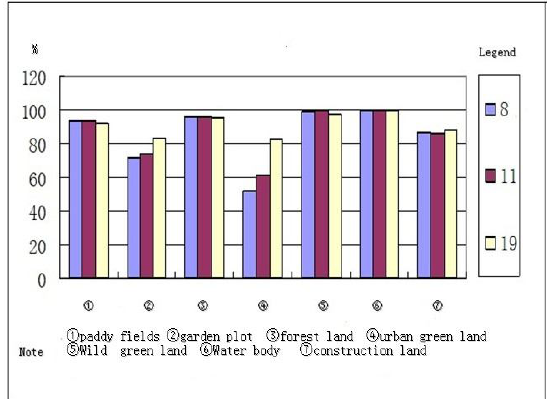
Figure5. Comparison of user's accuracy based different